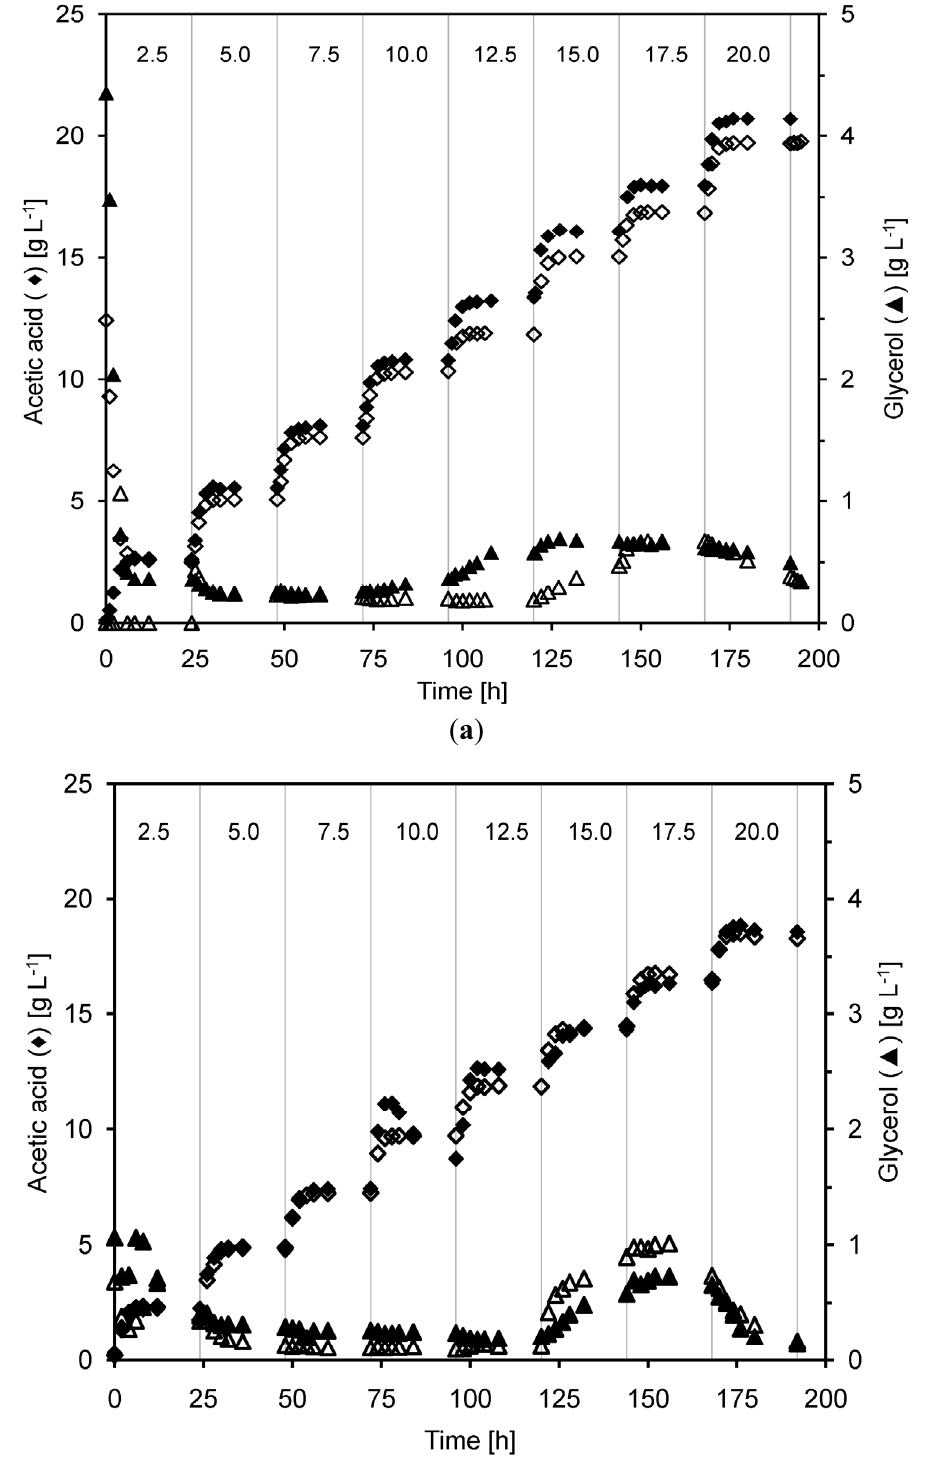
Figure 3. Concentration of glycerol and acetic acid in the outflow from the MBR, during two separate cultivations (closed) and (open symbols) at very high ( a ) and high ( b ) yeast concentration. The total acetic acid concentration in the feed medium was changed every 24 h (vertical lines). The numbers at the top of the figure denote the approximate total acetic acid concentration (in g·L − 1 ) during each such 24 h